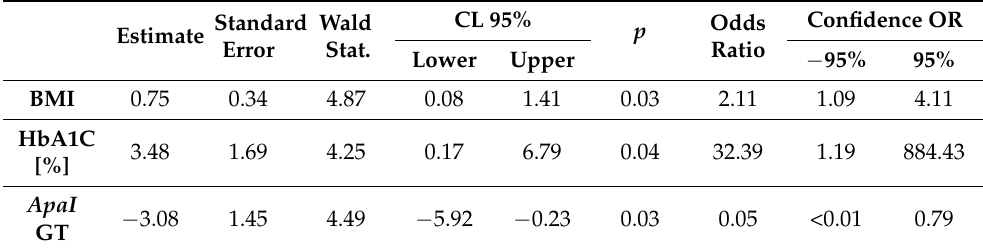
Table 7. Determinants of hypertension in the studied group of patients with cardiovascular